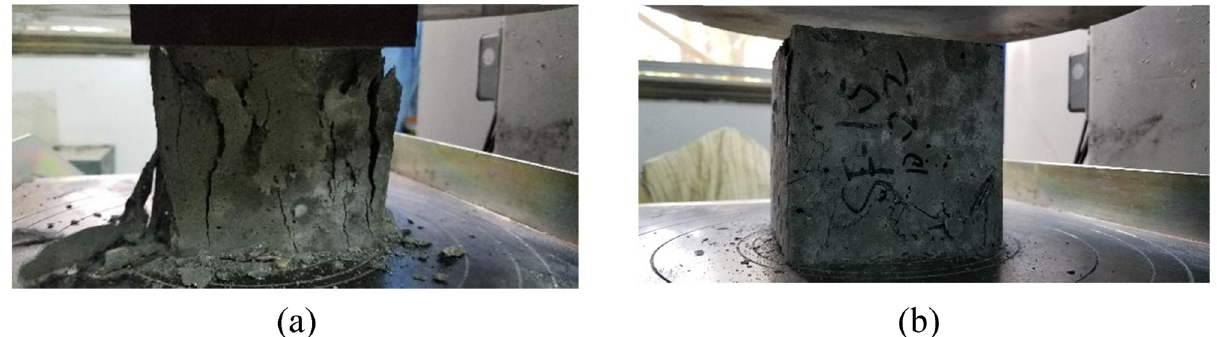
Figure 16: Test conditions of test block: ( a ) no added fi ber specimen and ( b ) fi ber - reinforced